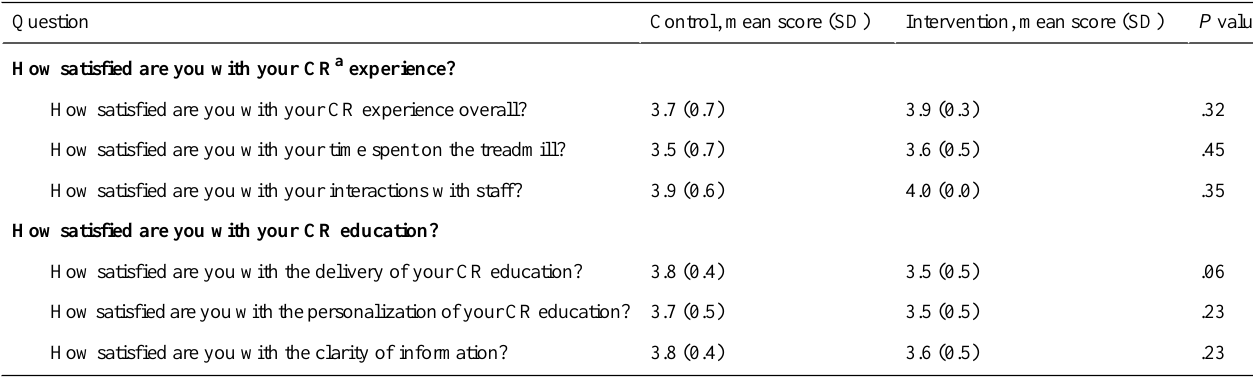
Table 2. Satisfaction survey questions (control: n=21 and intervention: